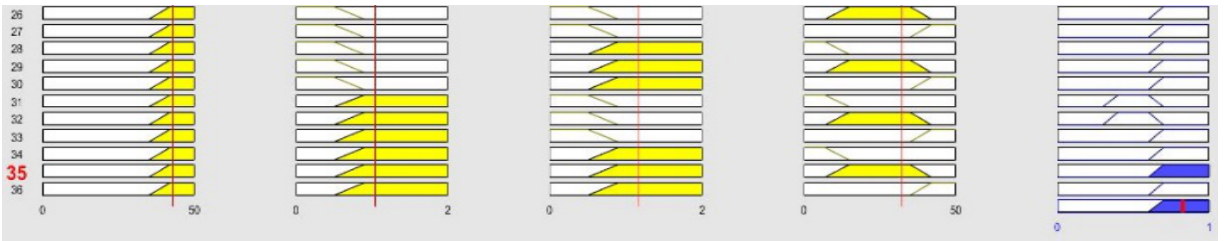
Figure 9. Lookup diagram of Proposed DA-AH-MFES Expert System for Chronic Arthritis